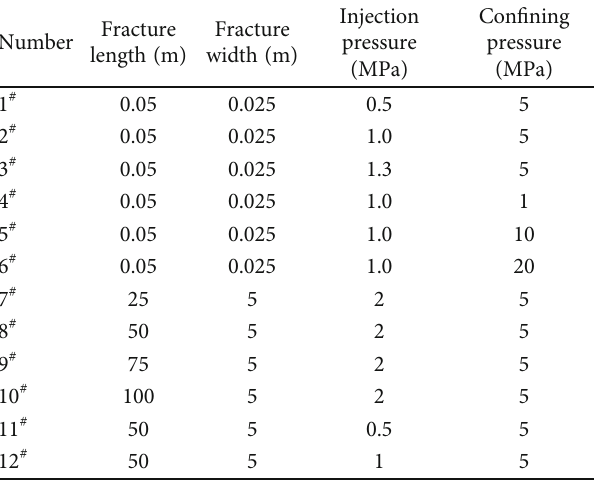
tial gel time of the grout material is correspond- ingly short [44, 45]